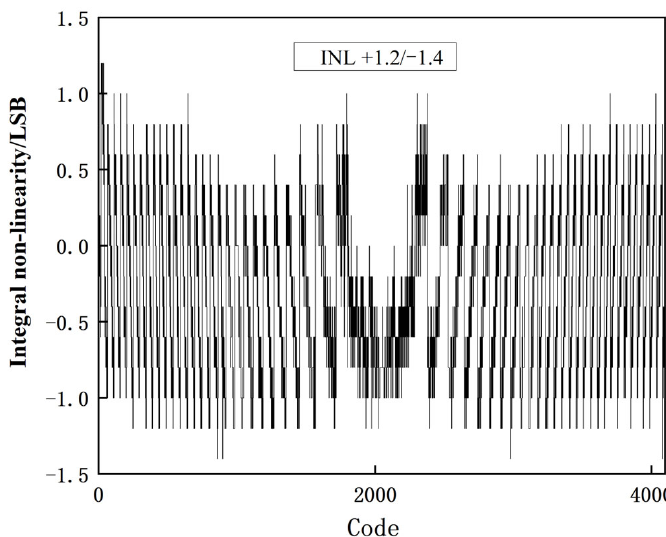
Figure 13. INL test result.